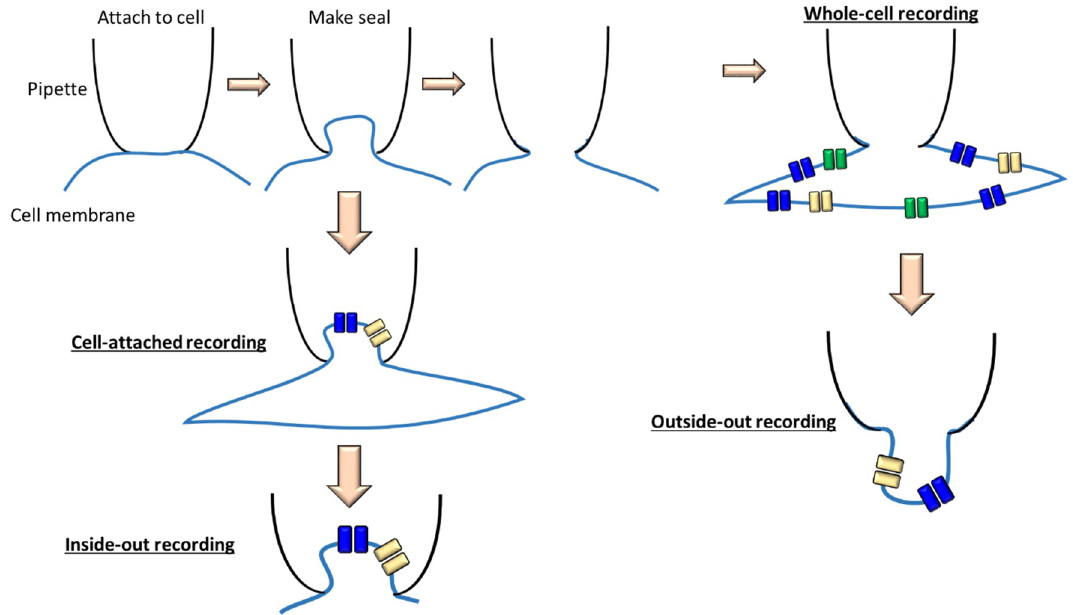
Figure 3. Patch-clamp electrophysiology. Formation of the giga seal and the subsequent cell-attached and whole-cell configuration. When the pipette is in closest proximity to the cell membrane, mild suction is applied to gain a tight seal between the pipette and the membrane. Whole-cell: By applying another brief but strong suction, the cell membrane is ruptured and the pipette gains access to the cytoplasm. Inside-out: In the cell-attached mode, the pipette is retracted and the patch is separated from the rest of the membrane and exposed to air. The cytosolic surface of the membrane is exposed. Outside-out: In the whole-cell mode, the pipette is retracted resulting in two small pieces of membrane that reconnect and form a small vesicular structure with the cytosolic side facing the pipette solution. A second configuration (Figure 3) is obtained by separating the pipette and patch from the